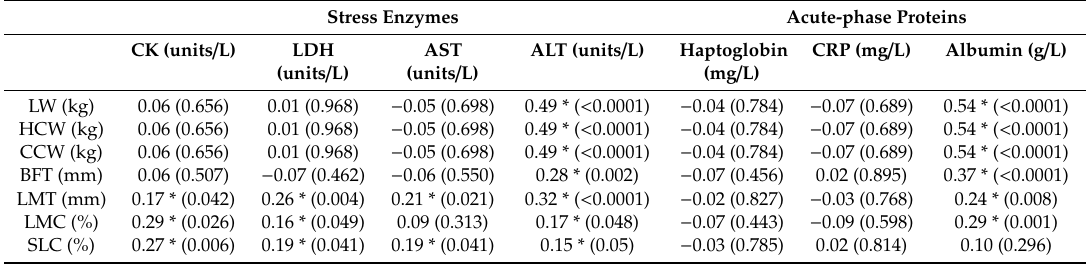
Table 5. Correlations (r) between stress enzymes, acute-phase proteins, and carcass quality traits in slaughter pigs. Stress Enzymes Acute-phase Proteins CK (units / L) LDH AST (units / L) (units /